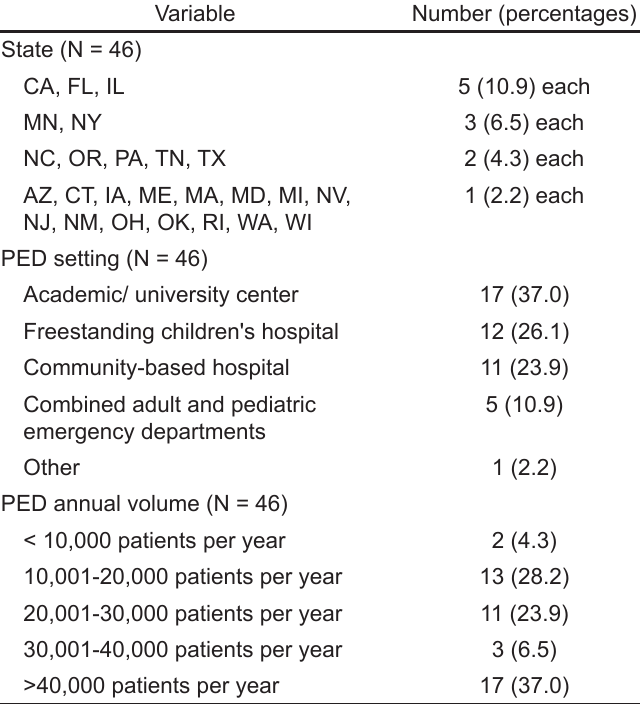
Table. Characteristics of survey